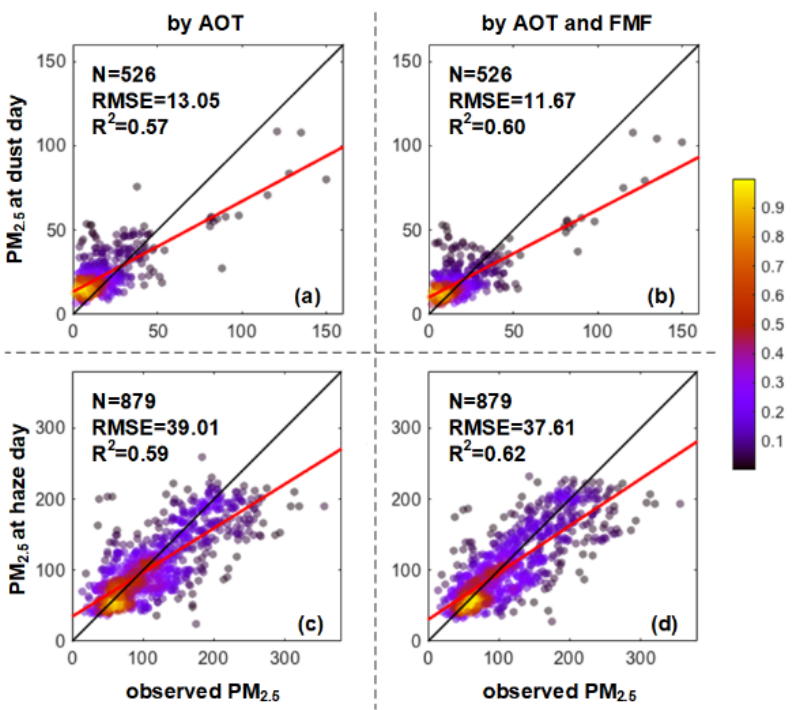
Figure 9. Density plot of EntityDenseNet retrieved PM 2.5 with ground-based PM 2.5 on dust ( a,b ) and haze ( c , d ) days in 2020 based on different Himwari-8 V3.0 input data (AOT only/AOT&FMF data). The black and red lines are 1:1 and fitting lines, respectively.